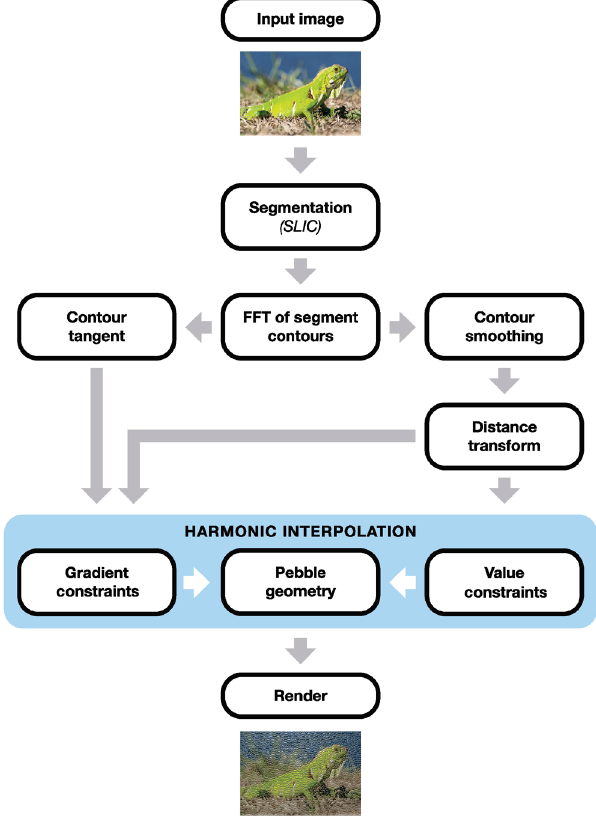
Fig. 3 Pipeline of our proposed